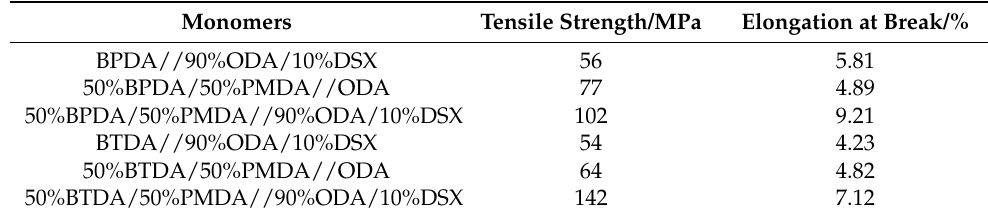
Table 5. Mechanical properties of PI films in groups 2 and